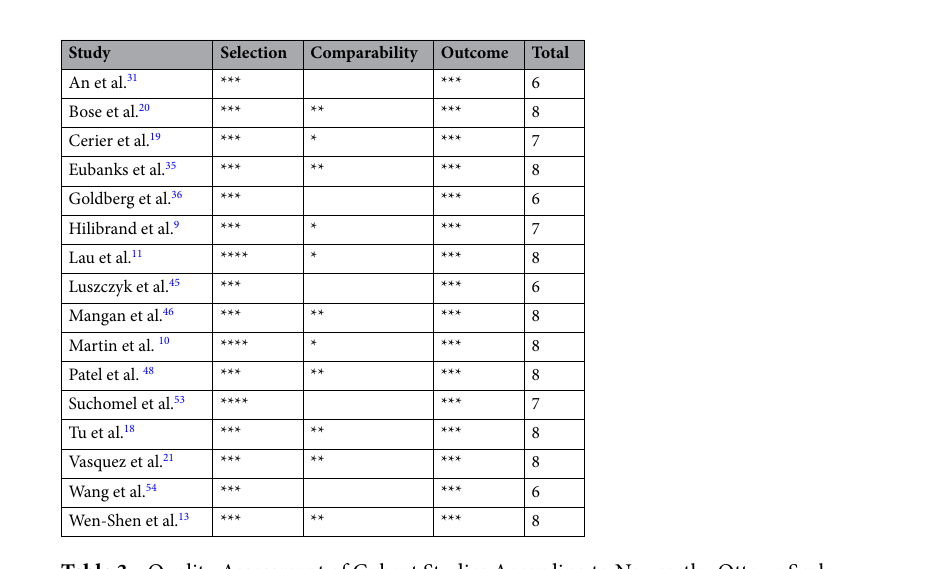
Table 3. Quality Assessment of Cohort Studies According to Newcastle–Ottawa